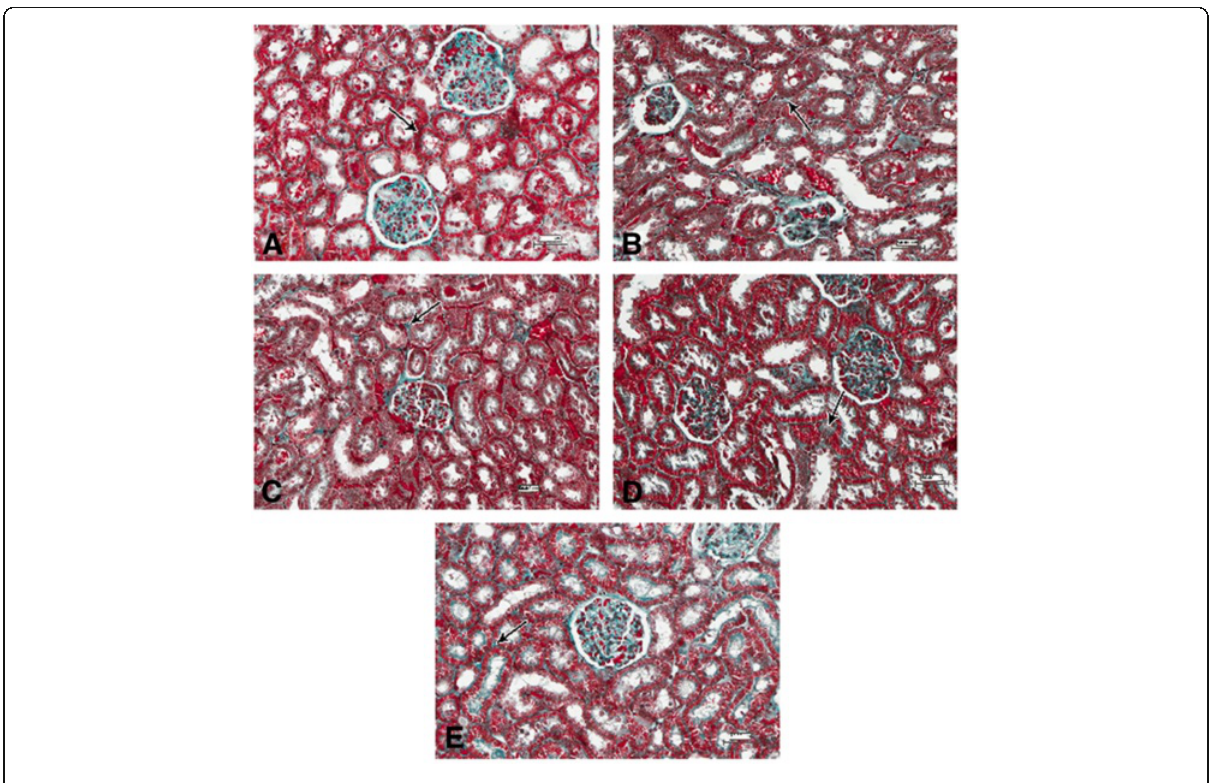
Figure 8 Photomicrographs of kidney sections stained with Masson trichrome (scale bars=50 μ m), showing the Control group (A) with normal distribution of a small amount of collagen fibers (arrow) between the renal tubules . (B) Intoxicated group with 1 g/kg body weight/day for 5 days with n-ZnO particles. There was an evident increase of deposition of collagen fibers in the interstitium (arrow). (C) Qur- treated group, an obvious increase of collagen fibers between the renal tubules (arrow). (D) Arg-treated group, there was a small amount of collagen fibers between the renal tubules (arrow). (E) Qur+Arg-treated group: Mild increase in collagen fibers between the renal tubules